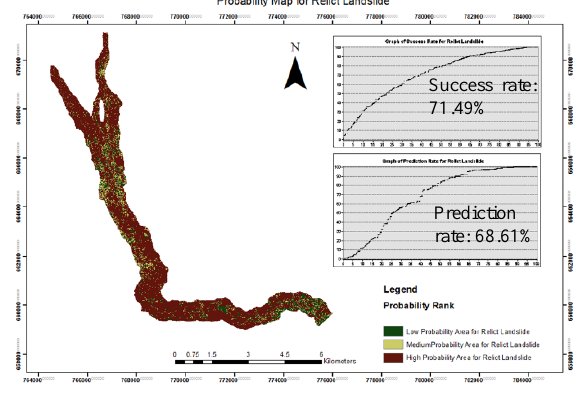
shown in Figure 21.